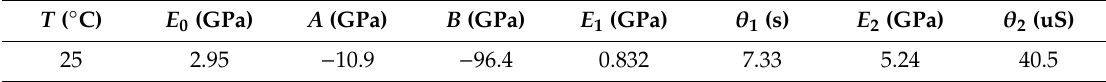
Table 3. Parameters for the rate-dependent viscoelasticity material. Figure 3. FEA model of a specimen with ( a ) cubic specimen with slenderness 0.66; ( b ) cylinder specimen with slenderness 0.66; ( c ) cylinder specimen with slenderness 0.5; ( d ) cylinder specimen with slenderness 1; ( e ) cylinder specimen with slenderness 1.5.